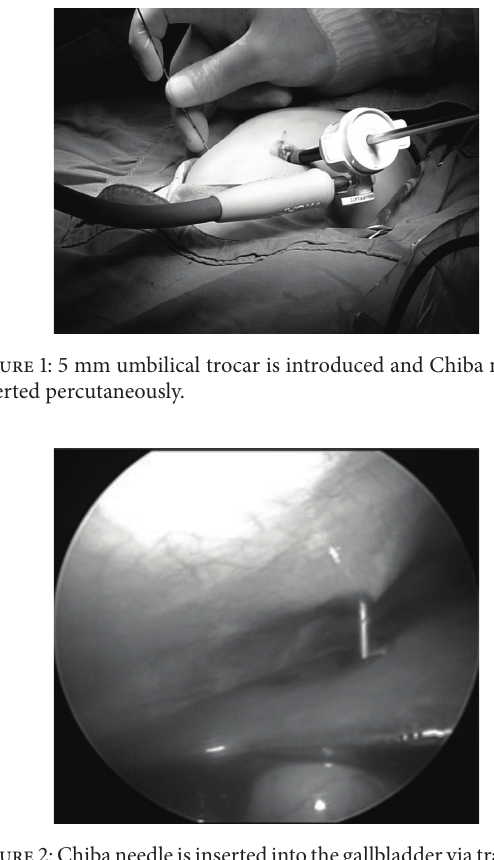
Figure2:Chibaneedleisinsertedintothegallbladderviatranspass- ing the liver under direct telescopic